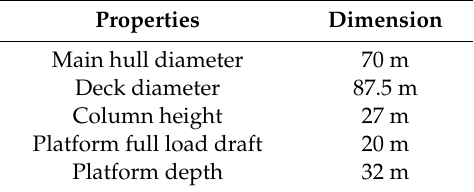
Table 7. Main dimensions of the FDP concept.